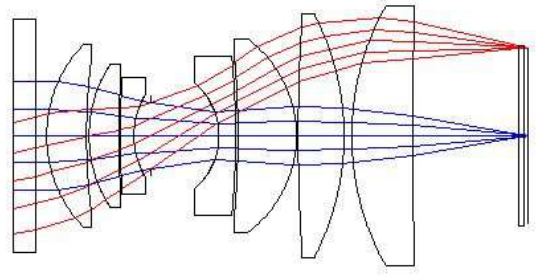
Figure 4. The structure of the optical system.